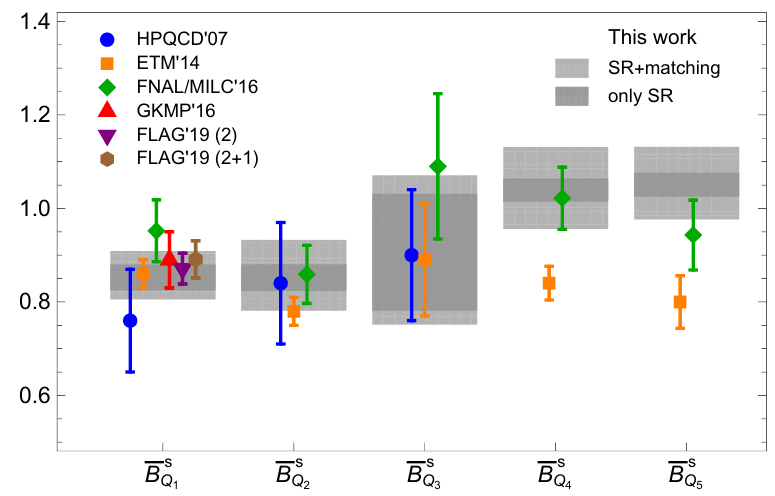
Figure 4 . Comparison of Bag parameters relevant for B s mixing. The dark gray regions indicate the ranges spanned only by the sum rule error whereas the light gray regions correspond to the total uncertainties. The sum rule value GKMP’16 corresponds to the result [13] for the B d system with an uncertainty of (cid:6) 0 : 02 for the m s e(cid:11)ects added in quadrature as suggested by the authors in [14].